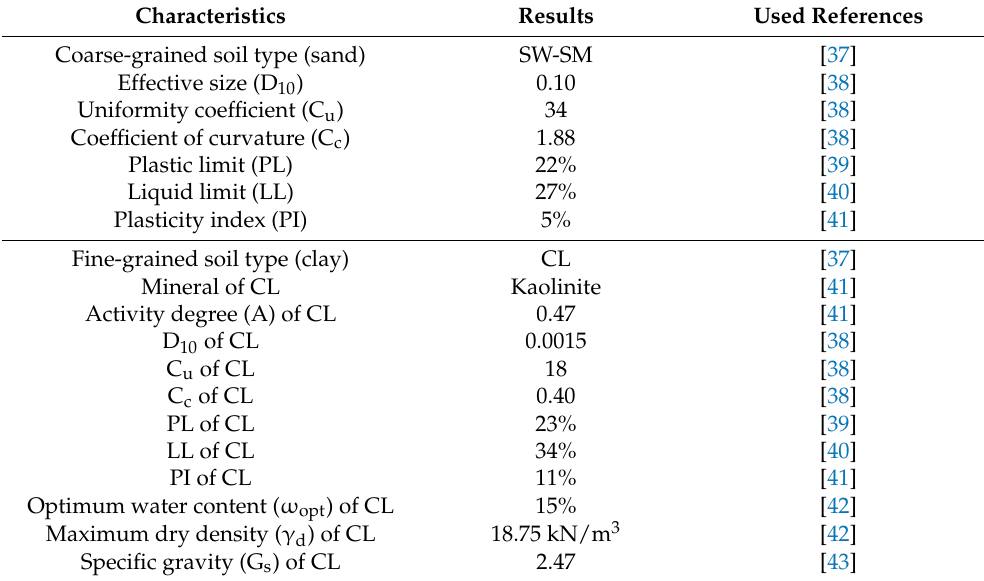
Figure 2. Grain size distribution curves of sand, rubber powder, and clay. Table 1. Properties of soils [24].